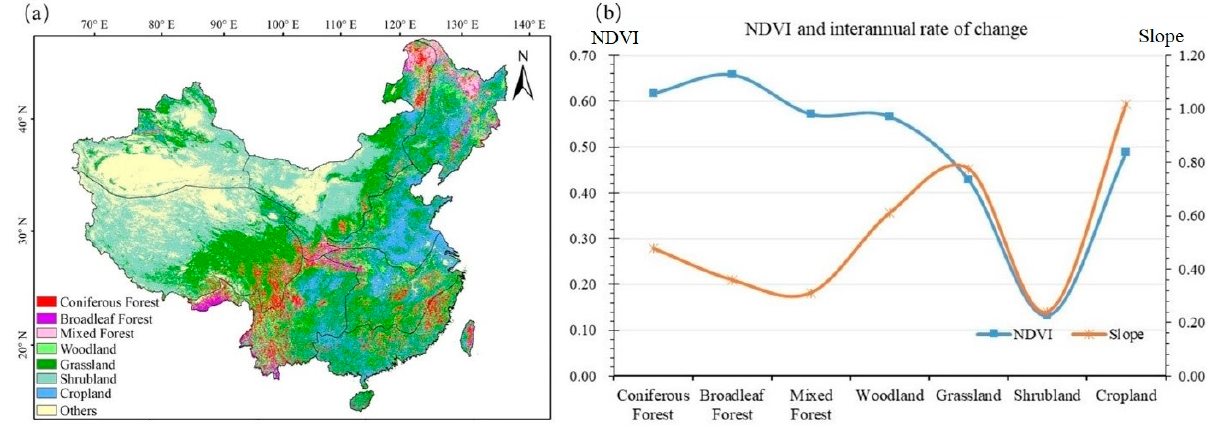
Figure 4. ( a ) Spatial distribution of vegetation types. ( b ) NDVI and interannual rate of change for vegetation